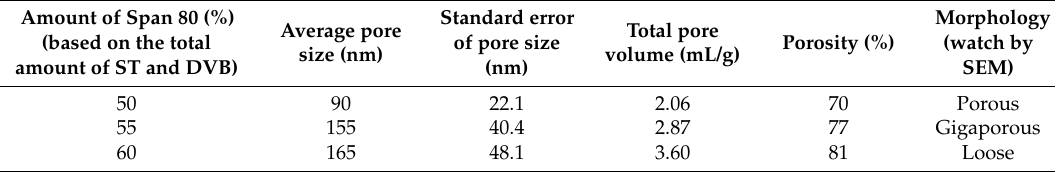
Figure 9. The photographs and mercury porosimetry measurements of the microspheres in optimized concentration of Span 80. ( a ) SEM (×500); ( b ) SEM (×30,000); ( c ) size distribution; and ( d ) mercury porosimetry measurements. Table 4. The pore characters with different Span 80.